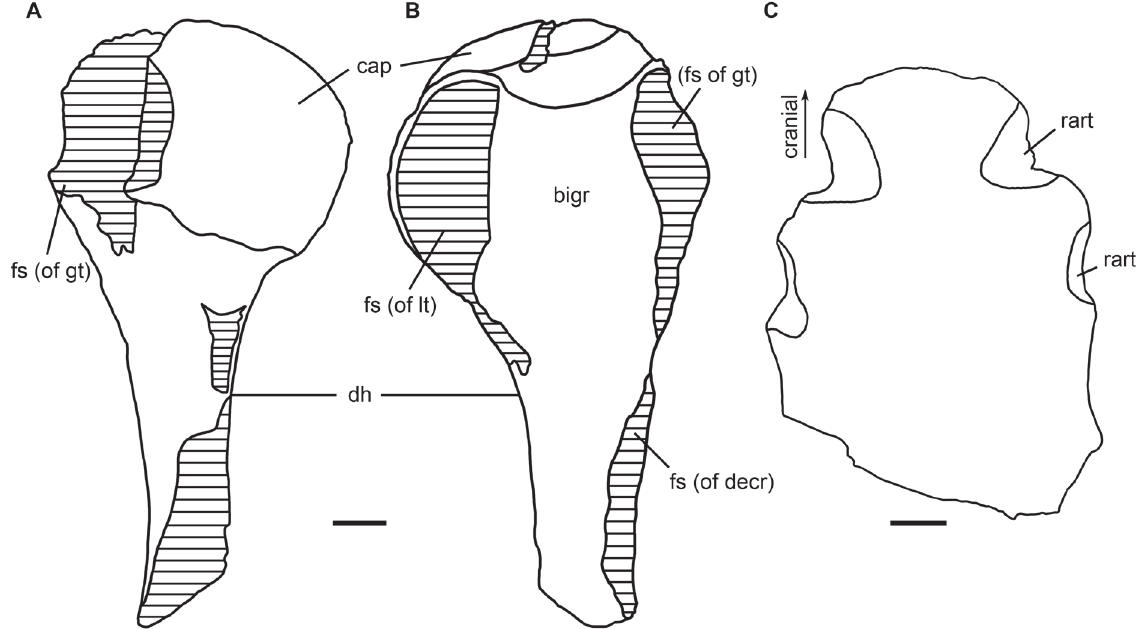
Fig. 9. Outline drawings of the left humerus LI 2012/4 and the xiphisternum OLL 2012/5 of Lentiarenium cristolii ( Fitzinger, 1842). A . Humerus in posterior view. B . Humerus in anterior view. C . Xiphisternum in ventral view. Shaded areas indicate missing parts. Scale bars = 1